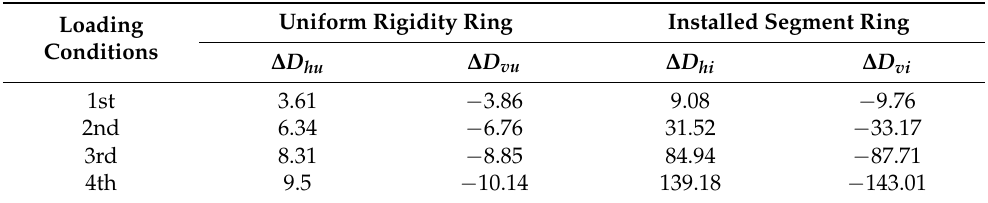
Table 4. Convergence deformations for the uniform rigidity ring and installed segment ring under different loading conditions (unit: mm).